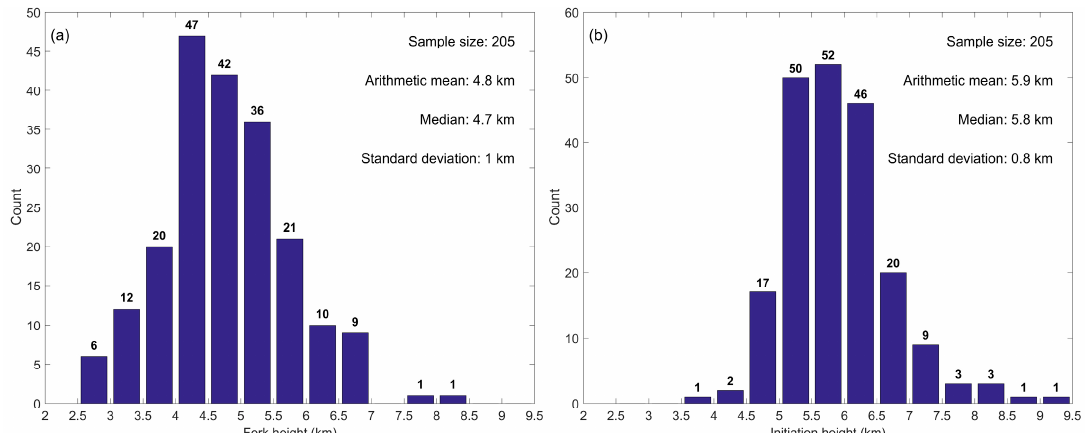
Figure 5. Histogram of the ( a ) leader fork height and ( b ) lightning initiation height.